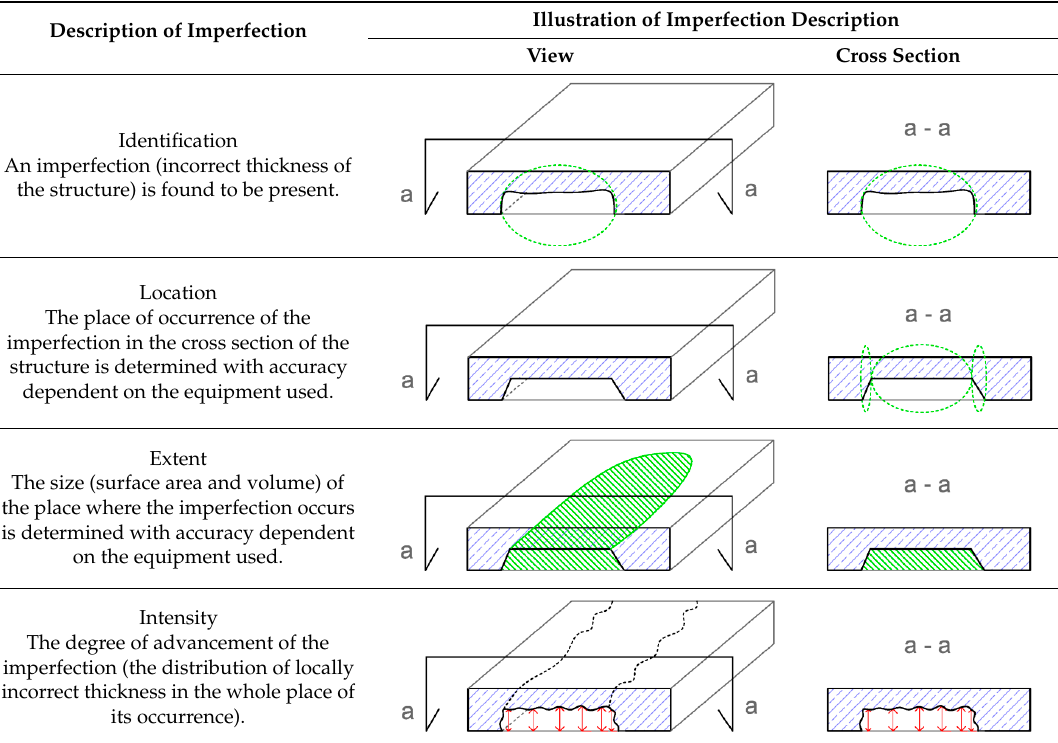
Table 2. Explanation of proposed terms for describing geometric imperfection in concrete structures tested by non-destructive acoustic methods.